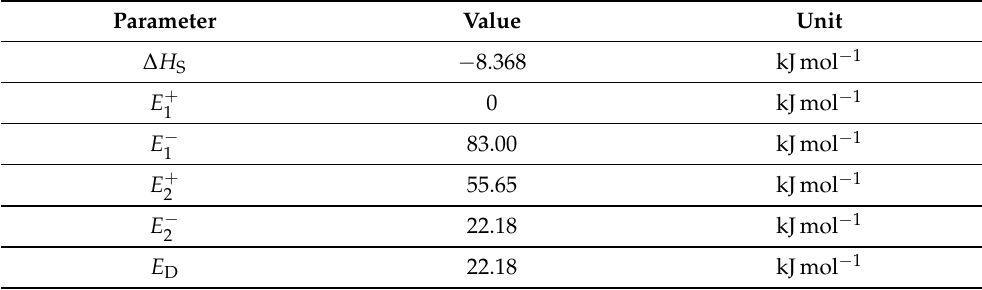
Table 3. Energetic parameters used for the modeling of palladium membranes, as proposed by Ward and Dao [13].